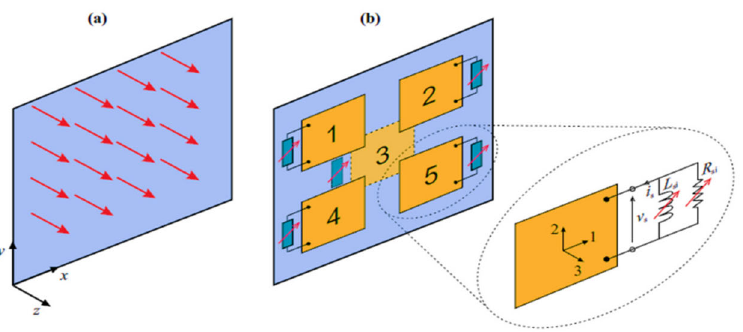
Figure 3. Vibration plate with shunted piezoelectric: ( a ) Stress generated by structural vibration; ( b ) Multiple piezoelectric patches integrated with microcircuits [43].